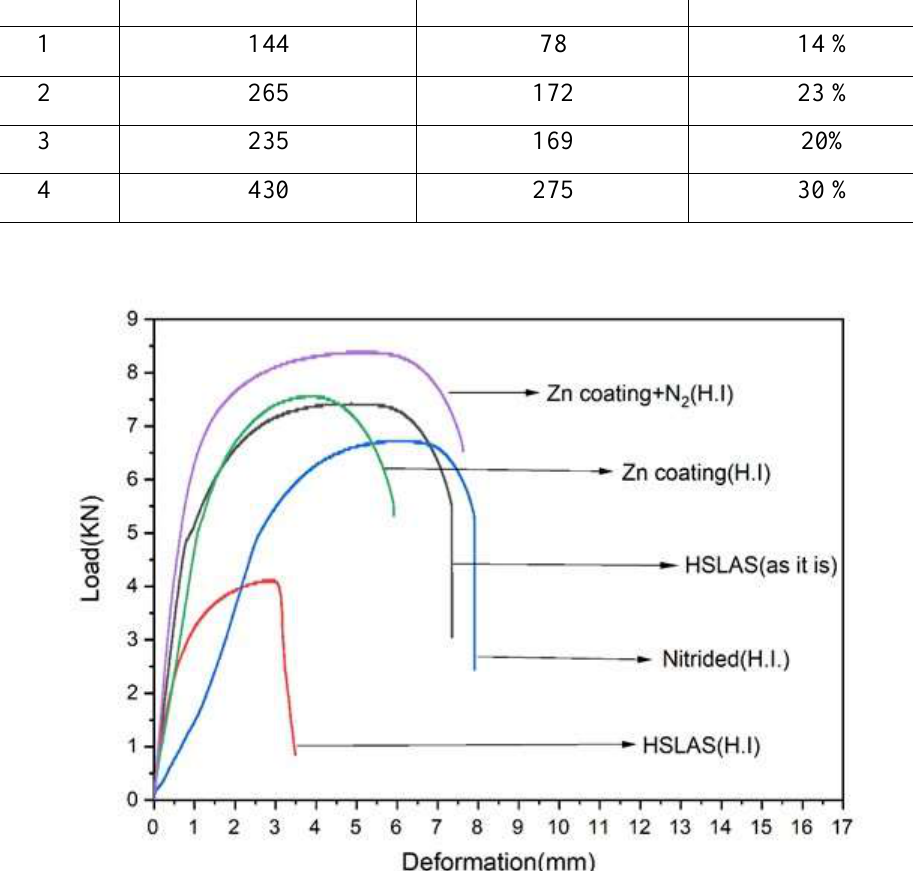
Figure 5: Force-deformation diagram resulted from tensile test for HSLAS with different surfaces